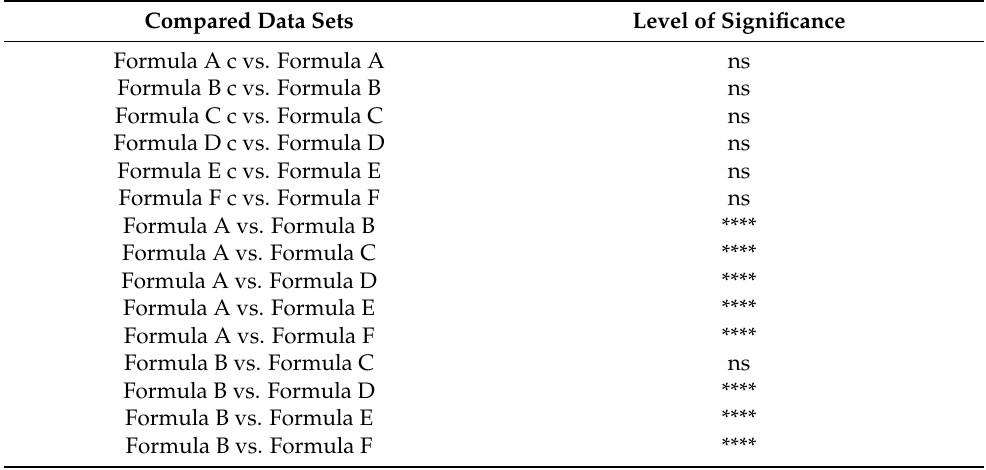
Table 1. Results of Tukey’s multiple comparison test generated by the data of textural